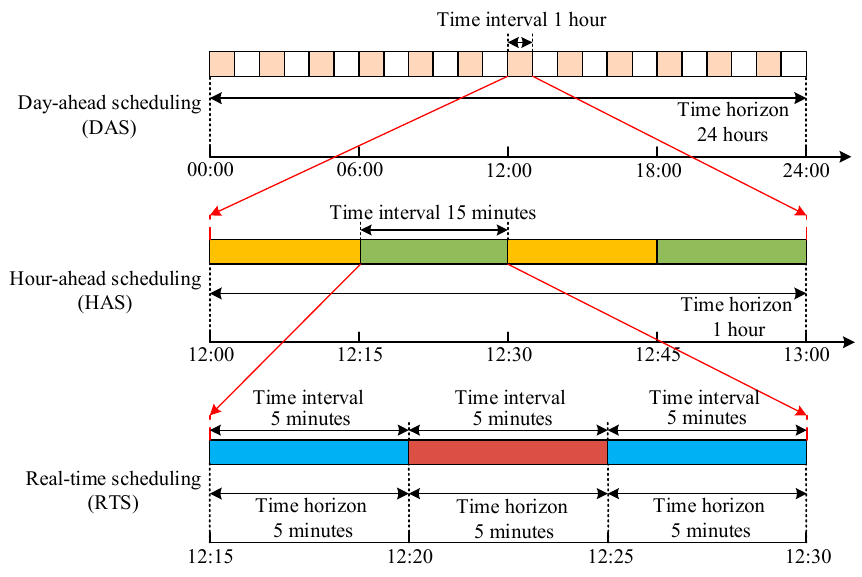
Figure 1. Relation among the DAS, HAS, and RTS.